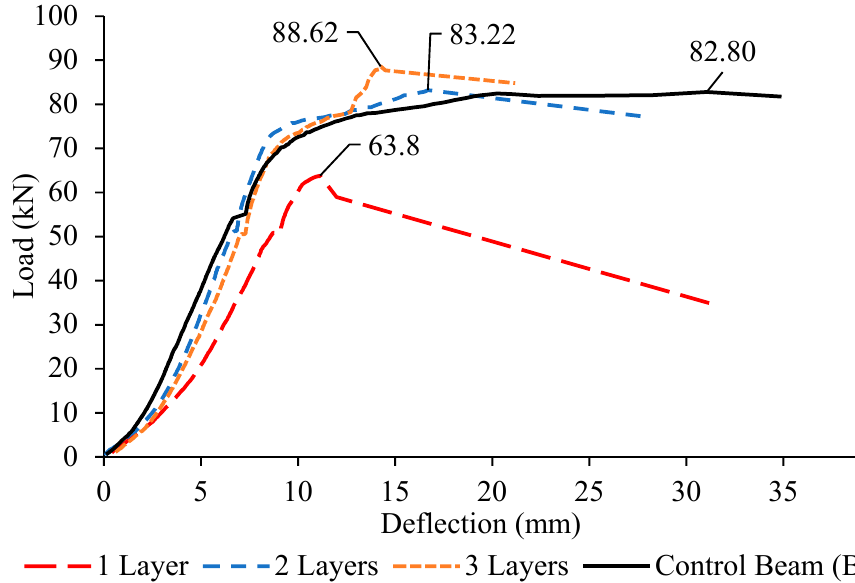
Figure 16. Load–deflection curves for Group 1 (B1a–B1c) deep beams and control beam.